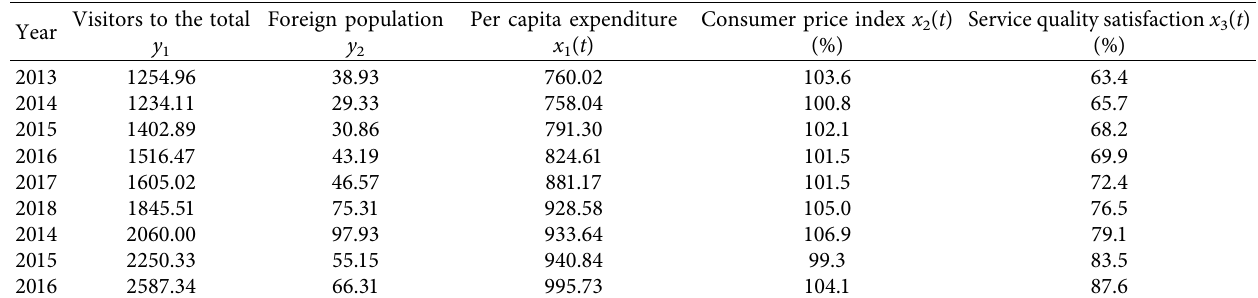
Table 2: Seasonal factors in the demand of ecotourism